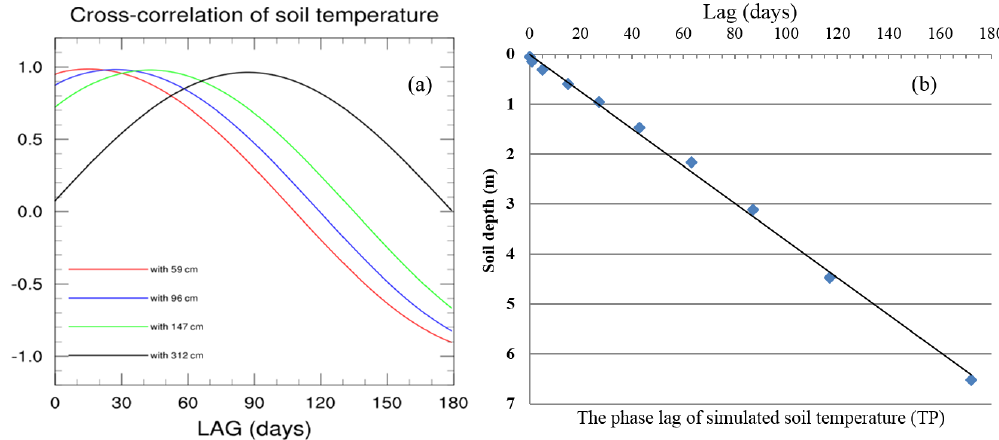
Figure 7. The time–space variability of soil temperature over the TP for 1978–2007. (a) Simulated cross-correlation of the first-layer soil temperature with other soil layers (red line: 59cm; purple line: 96cm; green line: 147cm; black line: 312cm) by SSiB3-FSM; (b) the phase lag (days) of simulated temperature over the TP by SSiB3-FSM.